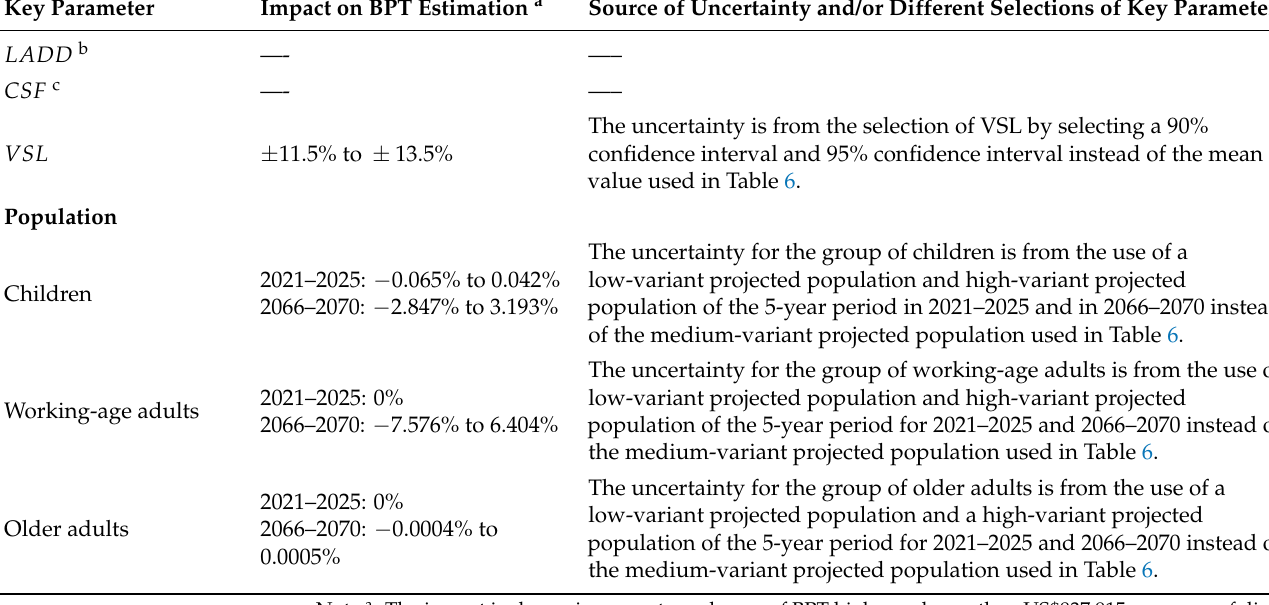
Table 9. The impact on BPT from each key